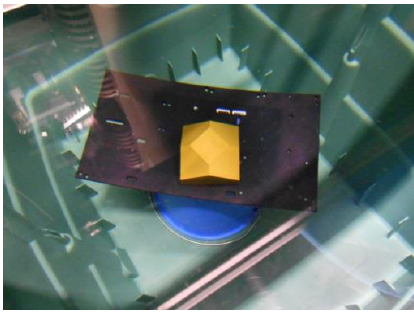
Figure 10. Pyramid stump in the rain barrel